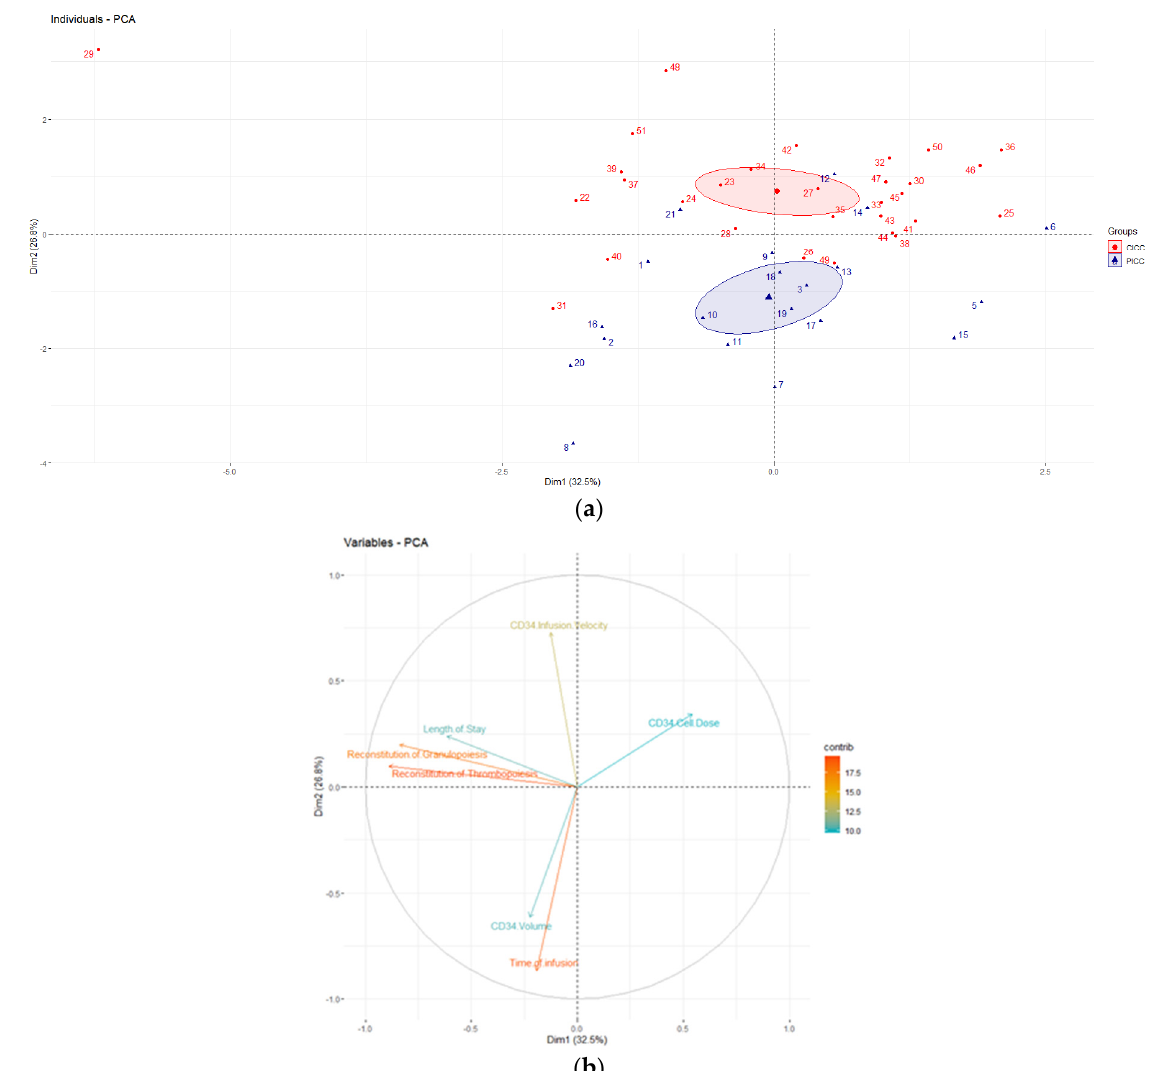
Figure 1. Principal component analysis (PCA) depicting the analyzed dataset. ( a ) Graph of individuals; ( b ) graph of variables.